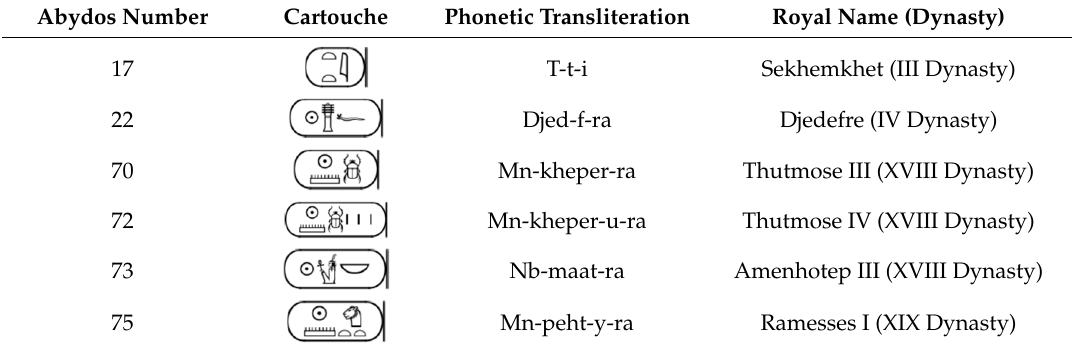
Table 2. List of selected cartouches for visualization purposes.